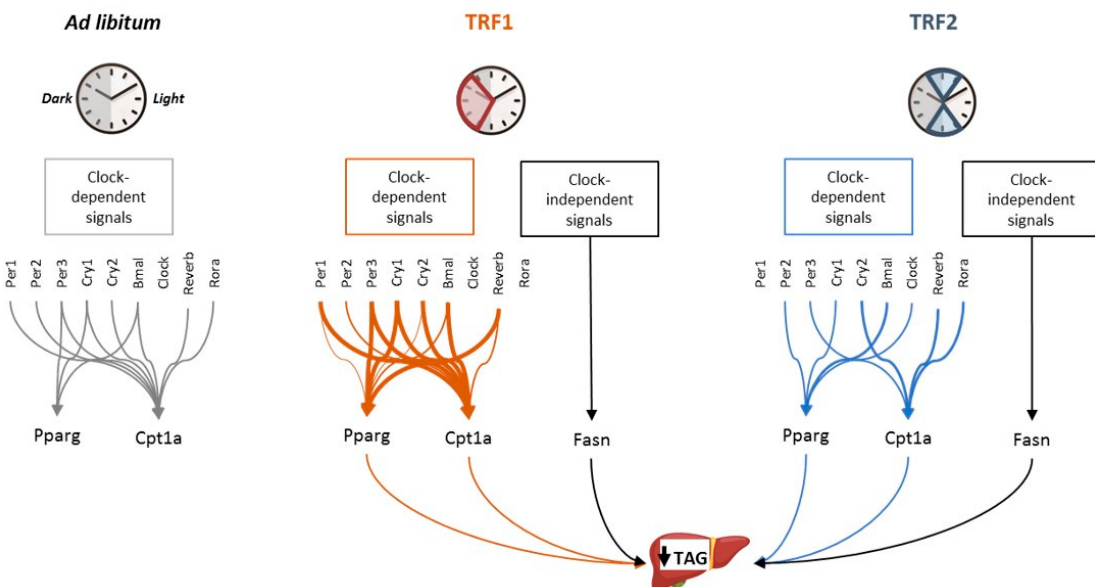
Figure 6. Working model-summary. The scheme represents the actual correlations established between clock genes and Fasn, Pparg and Cpt1a in SL mice (left panel). The TRF1 essentially strengthened the associations that already existed between the clock genes and Pparg-Cpt1a (central panel). This effect is typified with thicker arrows. The TRF2 introduced a new pattern of associations between the clock genes and Pparg-Cpt1a (right panel). Neither the TRF1 nor the TRF2 created any new significant association between the clock genes and Fasn. These data suggest that both interventions might contribute to reset hepatic TAG content through clock-dependent and clock-independent signals: Pparg and/or Cpt1a are re-set, in part, via clock genes, whereas Fasn is normalized through clock-independent mechanisms.